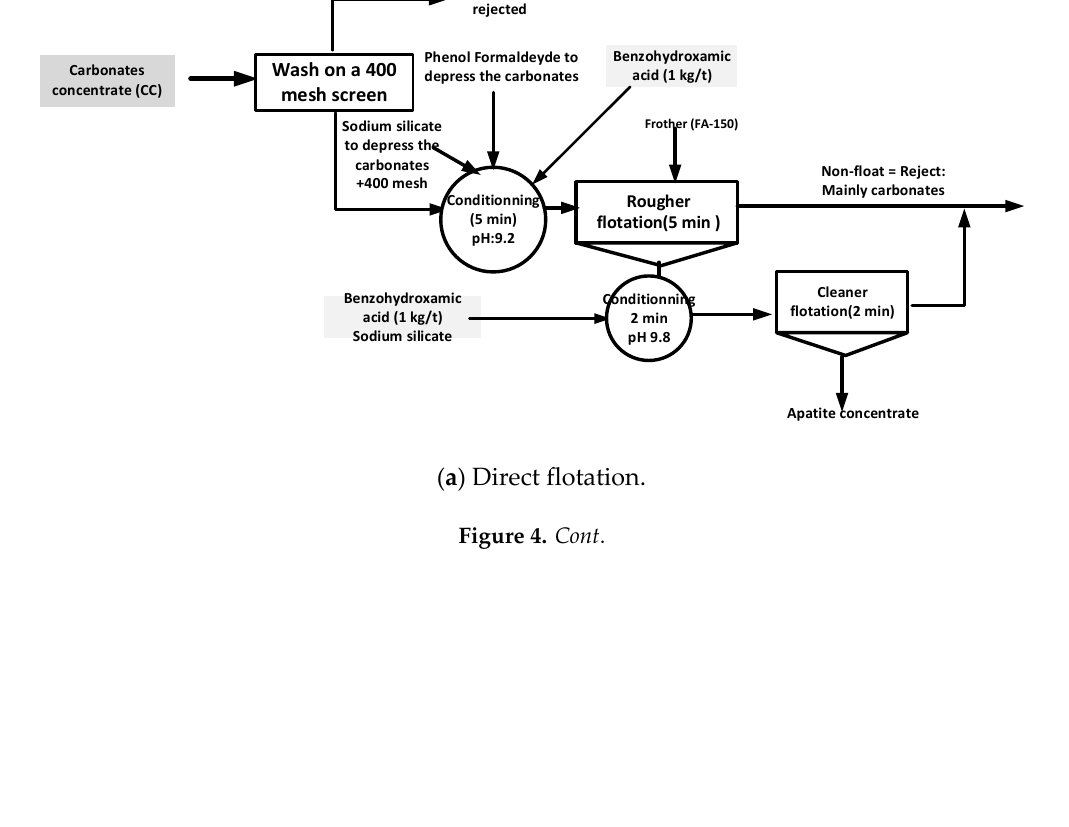
Table 5. Results of the pre-concentration using the hydrocyclone and the spiral concentrator (P 2 O 5 and MgO contents and distributions are average values of 4 repetitions ± the standard